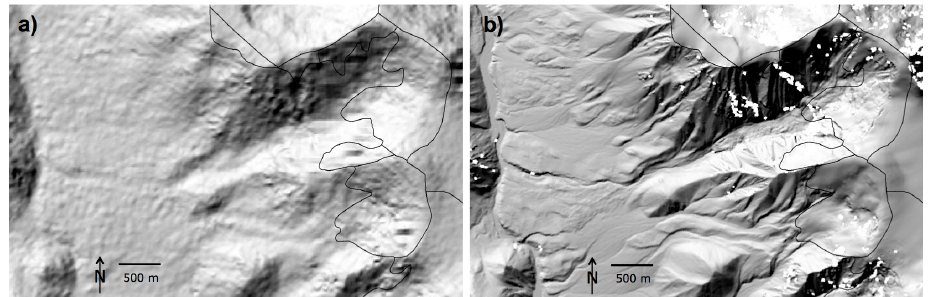
Figure 2. Visual comparison of the two DEMs for the region around the collapsed glacier (outlines from RGI6.0 in black). (a) The 30 m SRTM DEM from 2000 (source: earthexplorer.usgs.gov), (b) the